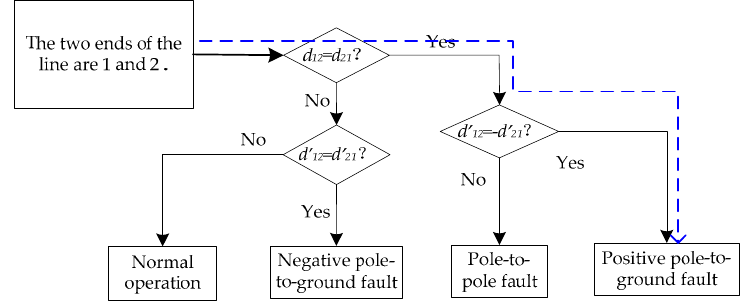
Figure 17. The algorithm flowchart under positive pole ‐ to ‐ ground short ‐ circuit fault.